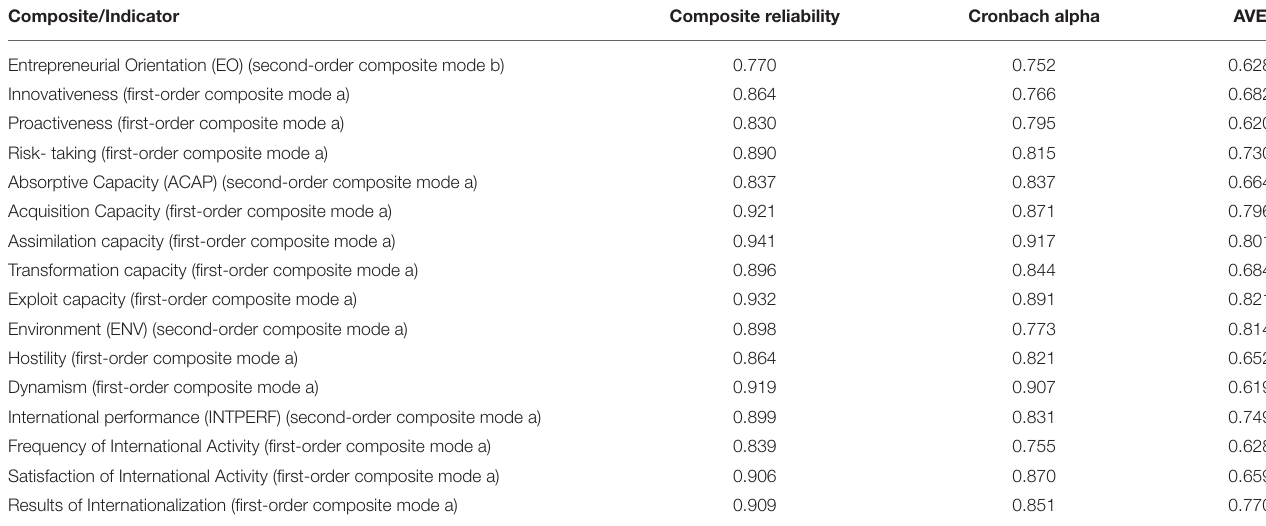
TABLE 2 | Composites and indicators.